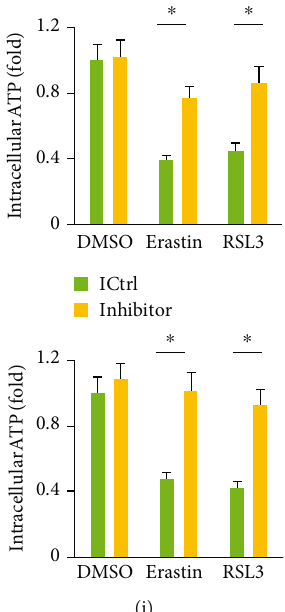
Figure 3: The miR-147a inhibitor prevents ferroptosis of human glioblastoma cells. (a) miR-147a level in human glioblastoma cells treated with or without the miR-147a inhibitor. (b) Cell viability detected by CCK-8 assay. (c) LDH level in the medium from cells treated with or without the miR-147a inhibitor. (d) ROS level detected by DCFH-DA probe. (e) MDA level in cells treated with or without the miR-147a inhibitor. (f) Relative level of intracellular iron. (g – h) Quanti fi cation of mtDNA content and integrity. (i) Quanti fi cation of intracellular ATP level. N = 6 for each group. Data were expressed as the mean ± SD , and P < 0 : 05 was considered statistically signi fi (Figure 3(f)). In addition, the miR-147a inhibitor signi fi - cantly prevented erastin- or RSL3-induced impairments of